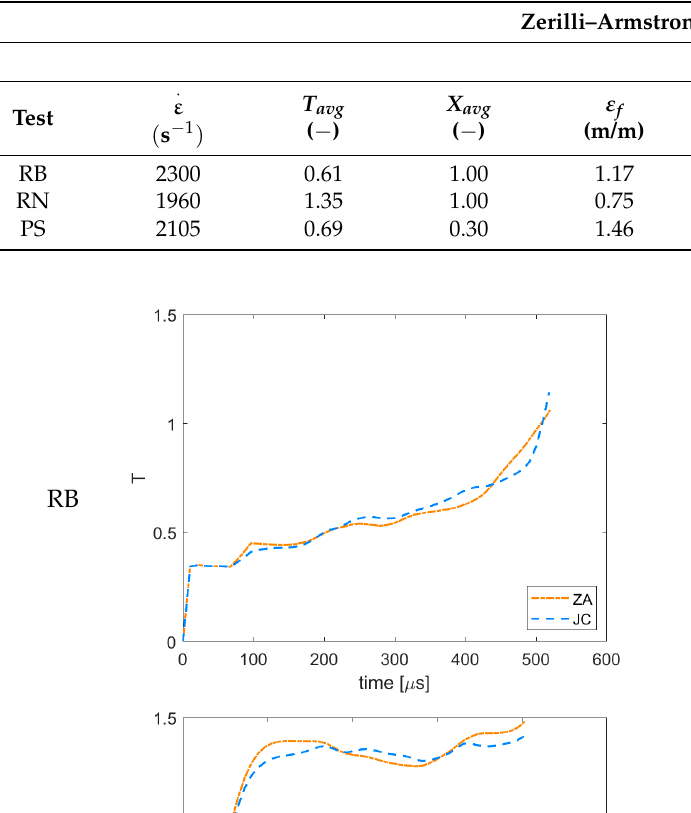
. ε ) , average T and X values; experimental strain ) and relative error (RE) as predicted by the CCF and BW f